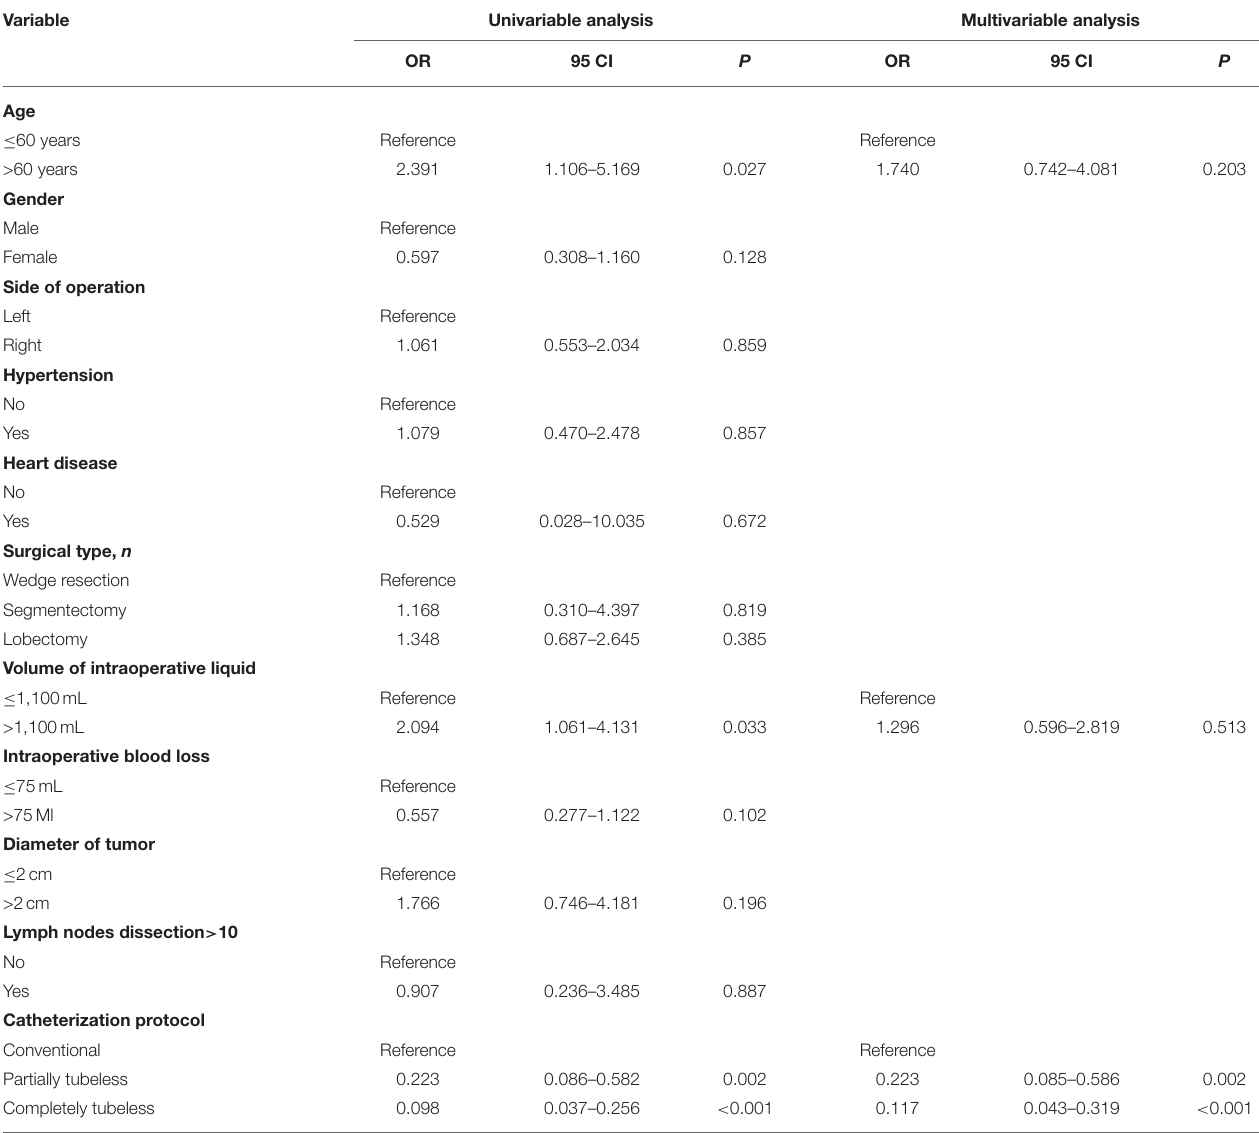
TABLE 4 | Regression analysis for predictive factors of urinary